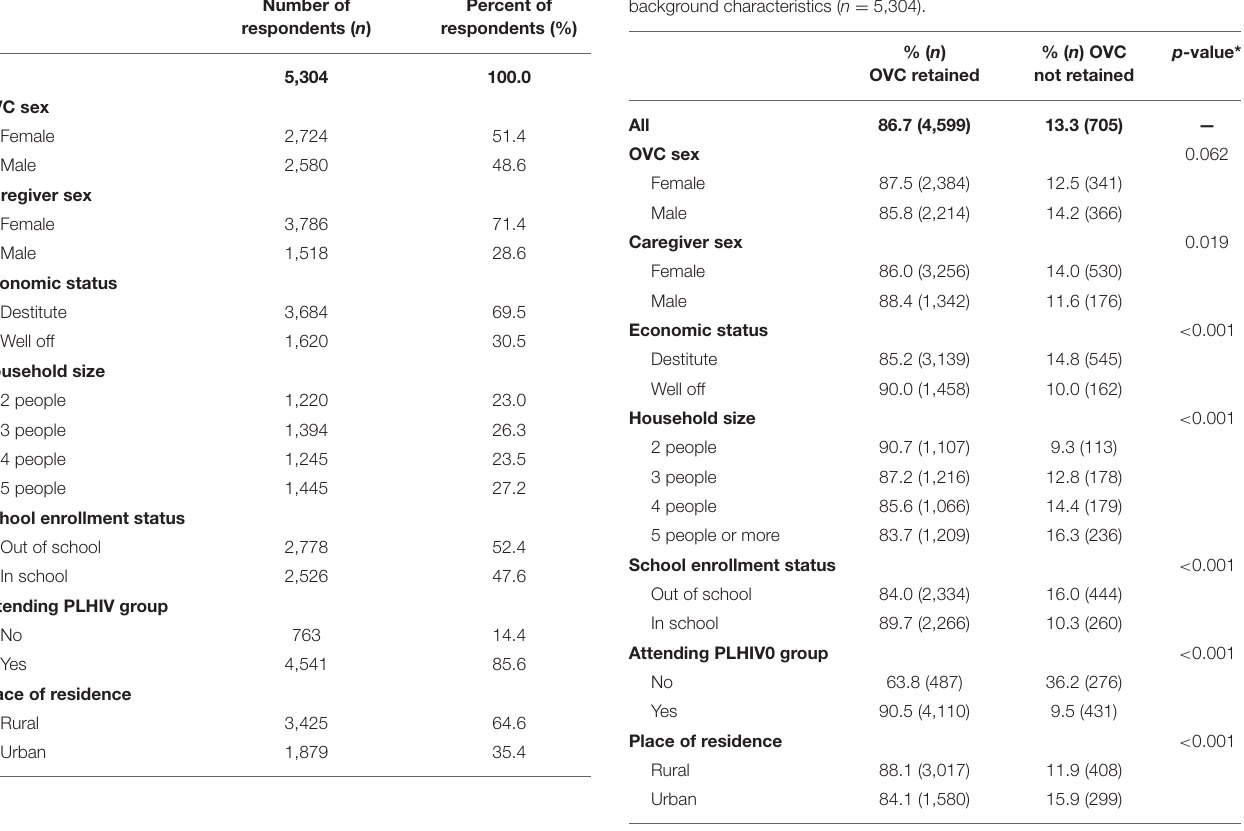
TABLE 1 | Profile of orphans and vulnerable children (OVC) analyzed. TABLE 2 | Cross-tabulation of orphans and vulnerable children (OVC) living with HIV retained, and not retained on ART at the end of 24 months of follow-up by background characteristics ( n =